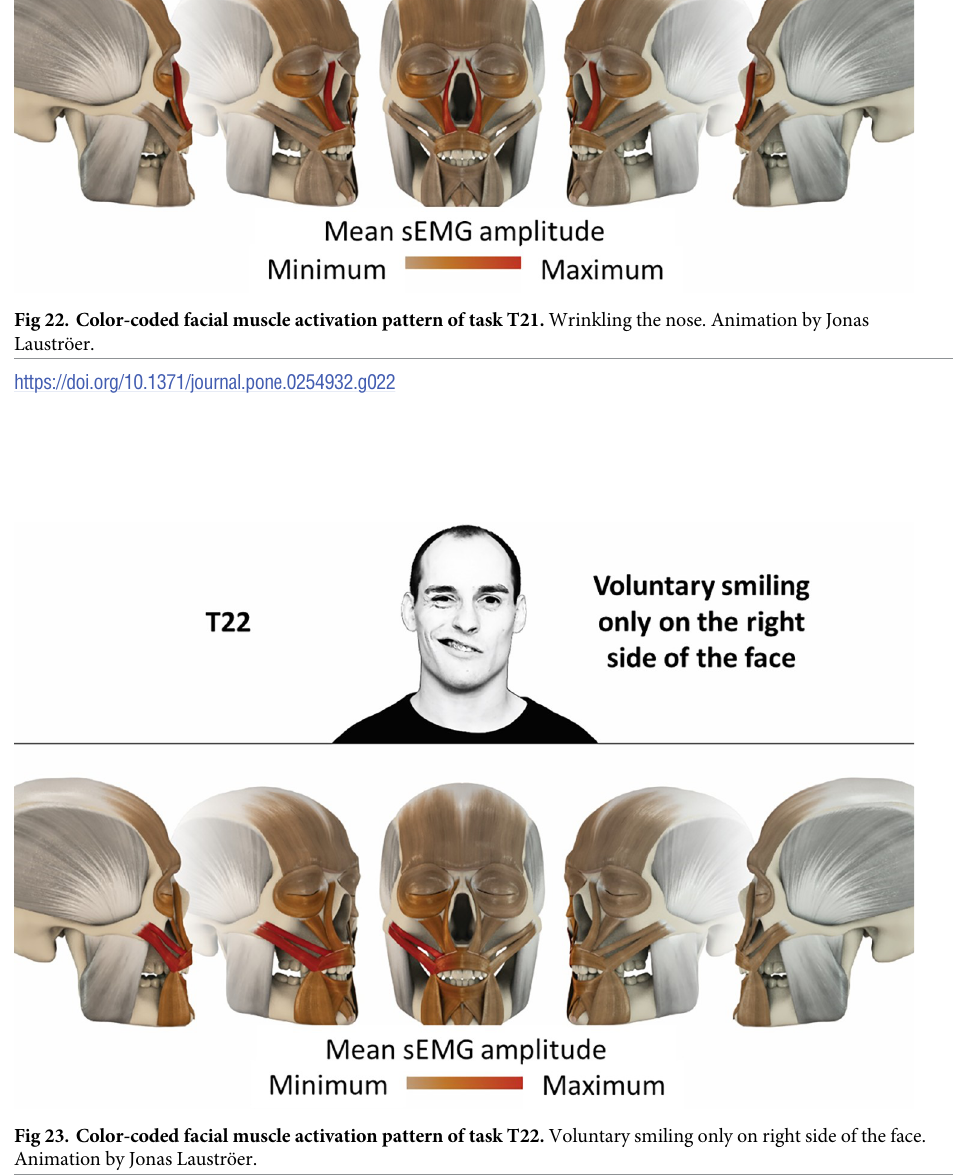
PLOS ONE | https://doi.org/10.1371/journal.pone.0254932 July 19,